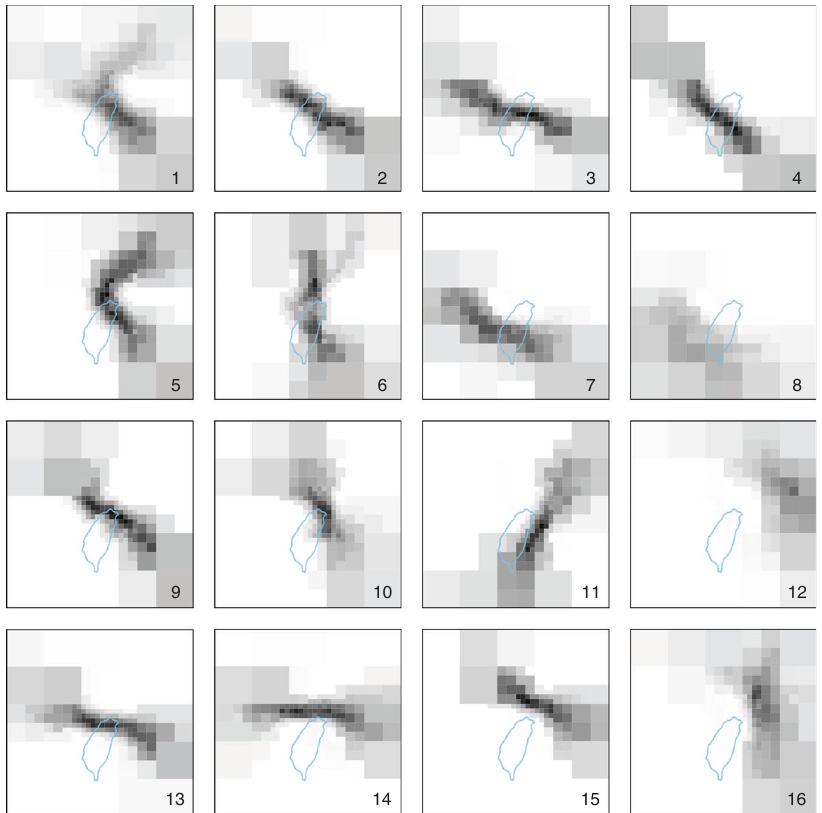
Fig. 2 Results of track vectorization of 87 typhoons. Vectorized typhoon tracks similar in shape are grouped in clusters based on the 4 × 4 self-organizing map. These sub fi gures include weight shading. Clusters are numbered, as shown in the bottom right corner of each